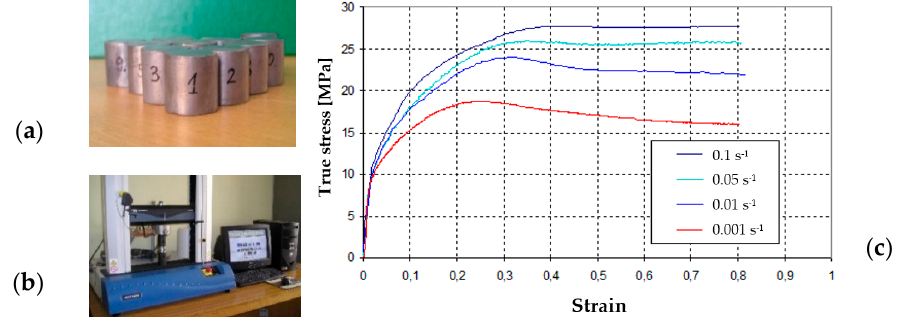
Figure 2. View of: ( a ) a set of samples for compression tests, ( b ) an image of the test station, ( c ) the flow curves for Pb.